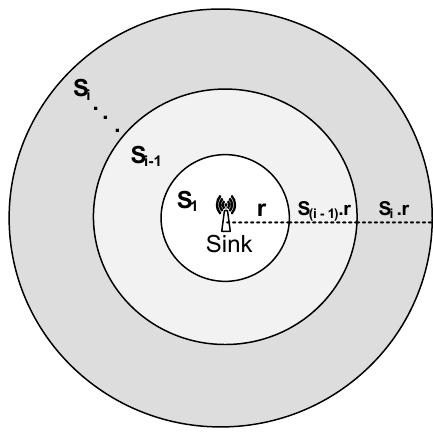
Figure 3. Network field division into ring